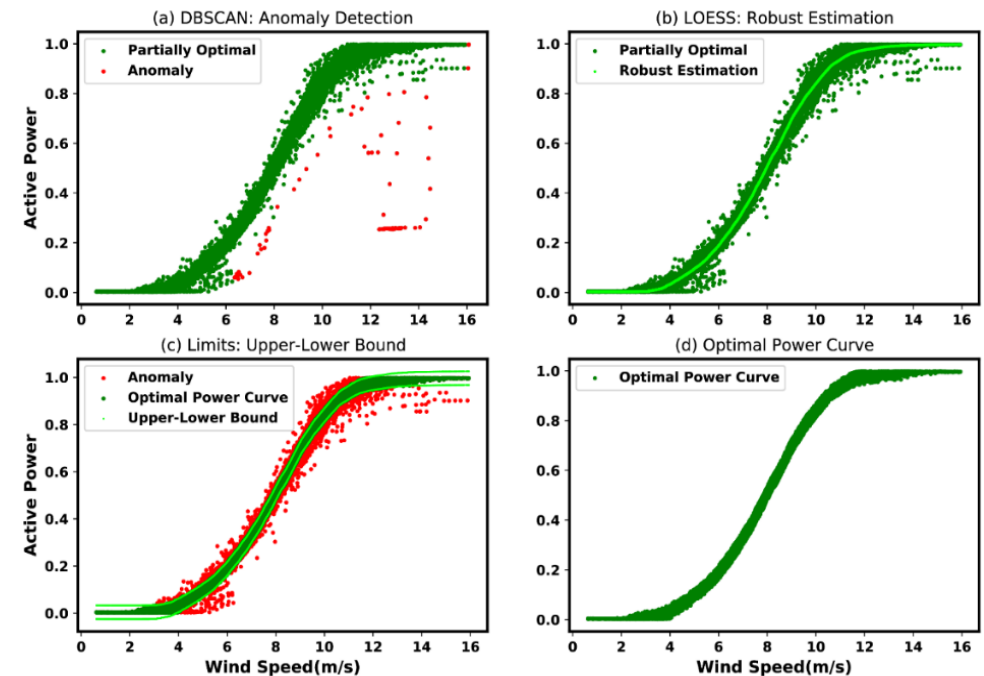
Figure 12. Combined methods to attain optimal (normal) power curve [21].